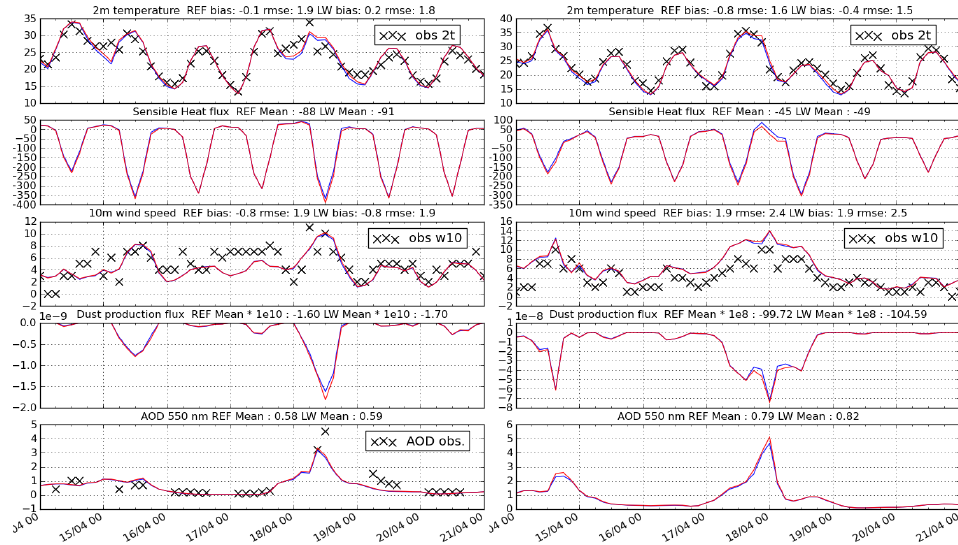
Figure 11. Same as Fig. 8 for REF (blue) vs. LW (red)